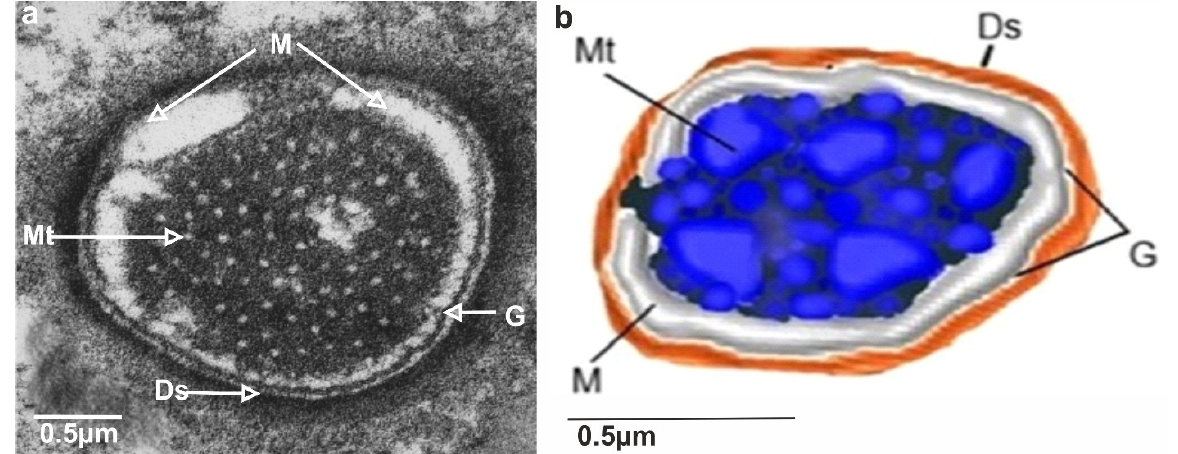
Figure 7. Model of the tubular body of trichoideum mechanosensillum in cross-section in N. rugosus : ( a ) original TEM photo of cross-section; ( b ) compilation of numerous thin slides to analyse particular components. Ds, dendrite sheath; G, line of granules; sf, suspension fibre; Mt, microtubules; M, membrane.